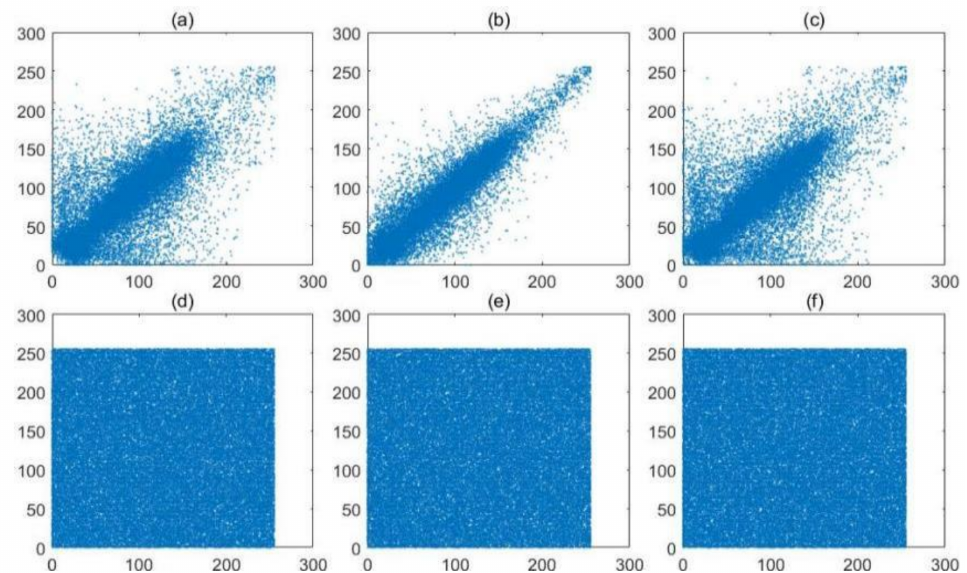
Figure 17. Correlation analysis of Flower image: ( a ) Adjacent pixel points of the plain-text image in horizontal direction; ( b ) Adjacent pixel points of the plain-text image in vertical direction; ( c ) Adjacent pixel points of the plain-text image in diagonal direction; ( d ) Adjacent pixel points of the encrypted image in horizontal direction; ( e ) Adjacent pixel points of the encrypted image in vertical direction; ( f ) Adjacent pixel points of the encrypted image in diagonal direction.